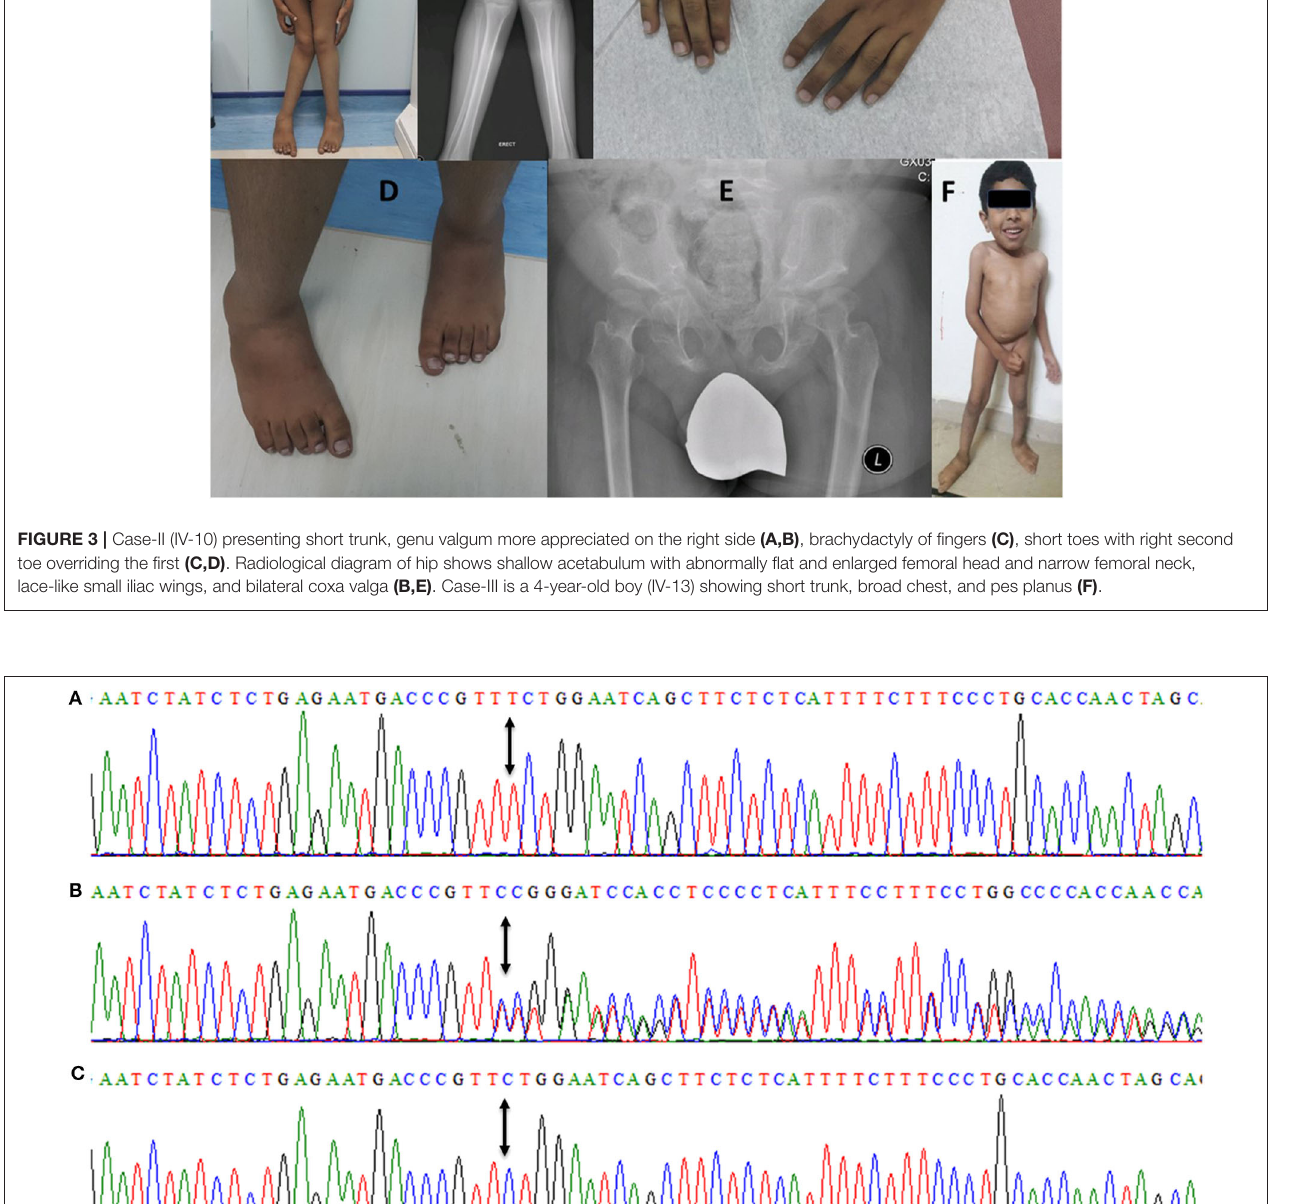
Frontiers in Pediatrics | www.frontiersin.org